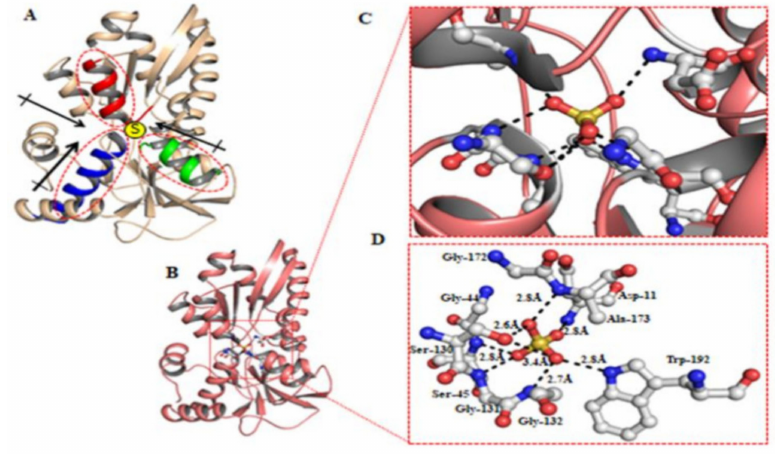
Figure 1. Computational analysis. Molecular docking of sulfate binding protein from Salmonella typhimurium. ( A ) Depiction of three α -helices form. ( B ) The oxygen atom of sulfate ion o ff ers seven hydrogen bonds to amino acid residues of sbp. ( C ) Enlarge the view of sulfate ion o ff ers seven hydrogen bonds to amino acid residues. ( D ) Two hydrogen bonds to Ser130 (2.6 and 3.4Å) of sbp, one with Ala173 (2.8 Å), one with Asp11 (2.8 Å), one with Ser45 (2.8 Å), one hydrogen bonds with Trp192 (2.8 Å), one bond with Gly131 (2.7 Å), and one bond with Gly132 (2.7 Å).